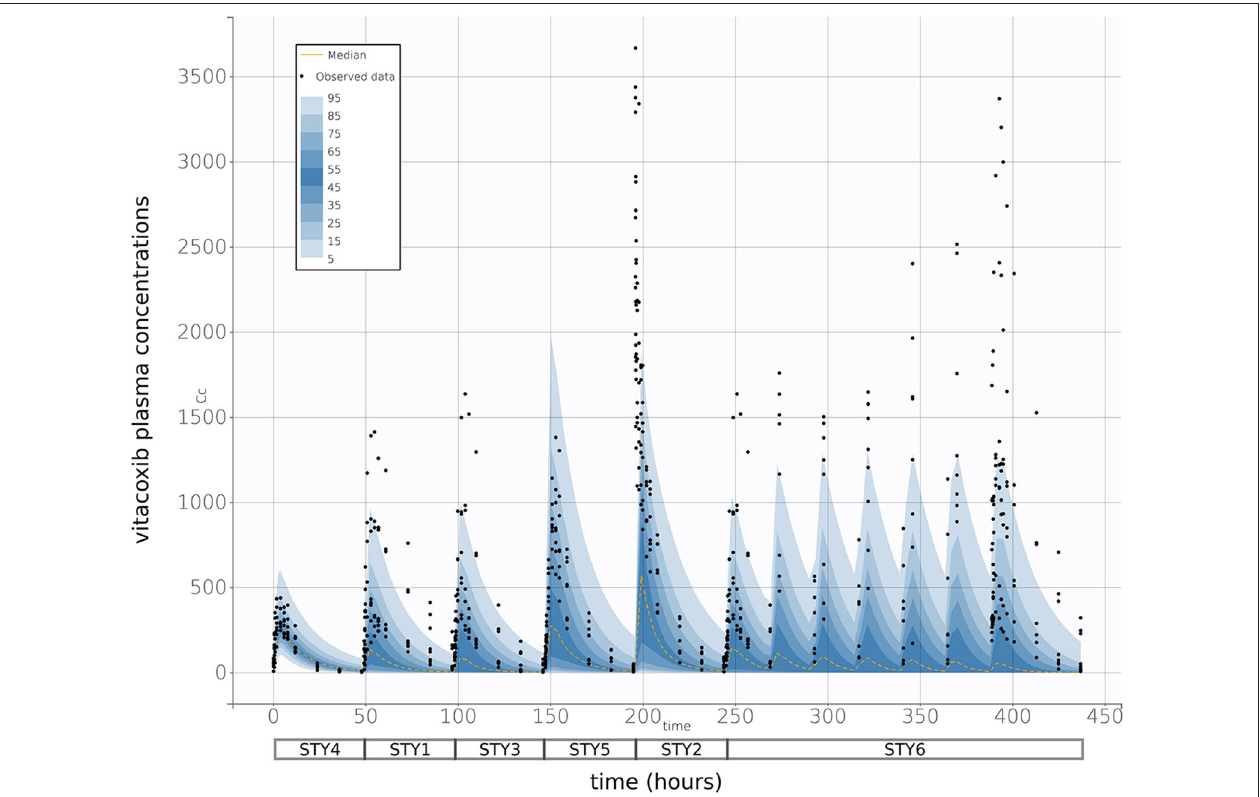
FIGURE 5 | Prediction distribution vs. observations. As described in Wang et al. (15), theoretical distribution of predictions was produced by 500 Monte Carlo simulation from the model fit. Briefly, the experiment was replicated virtually 500 times, allowing for each quantile (from 5 to 95 in steps of 5, i.e., {5, 10, 15,…,90, 95}) to be estimated 500 times. The blue areas are ranges of quantiles and the black points are observations for comparison. The yellow lines are median predictions, and studies are aligned sequentially—as indicated by the boxes below the x -axis. With a 95% prediction interval, we would expect that there would be some degree of misspecification, but the high general correspondence between model and observations indicate a strong fit performance.